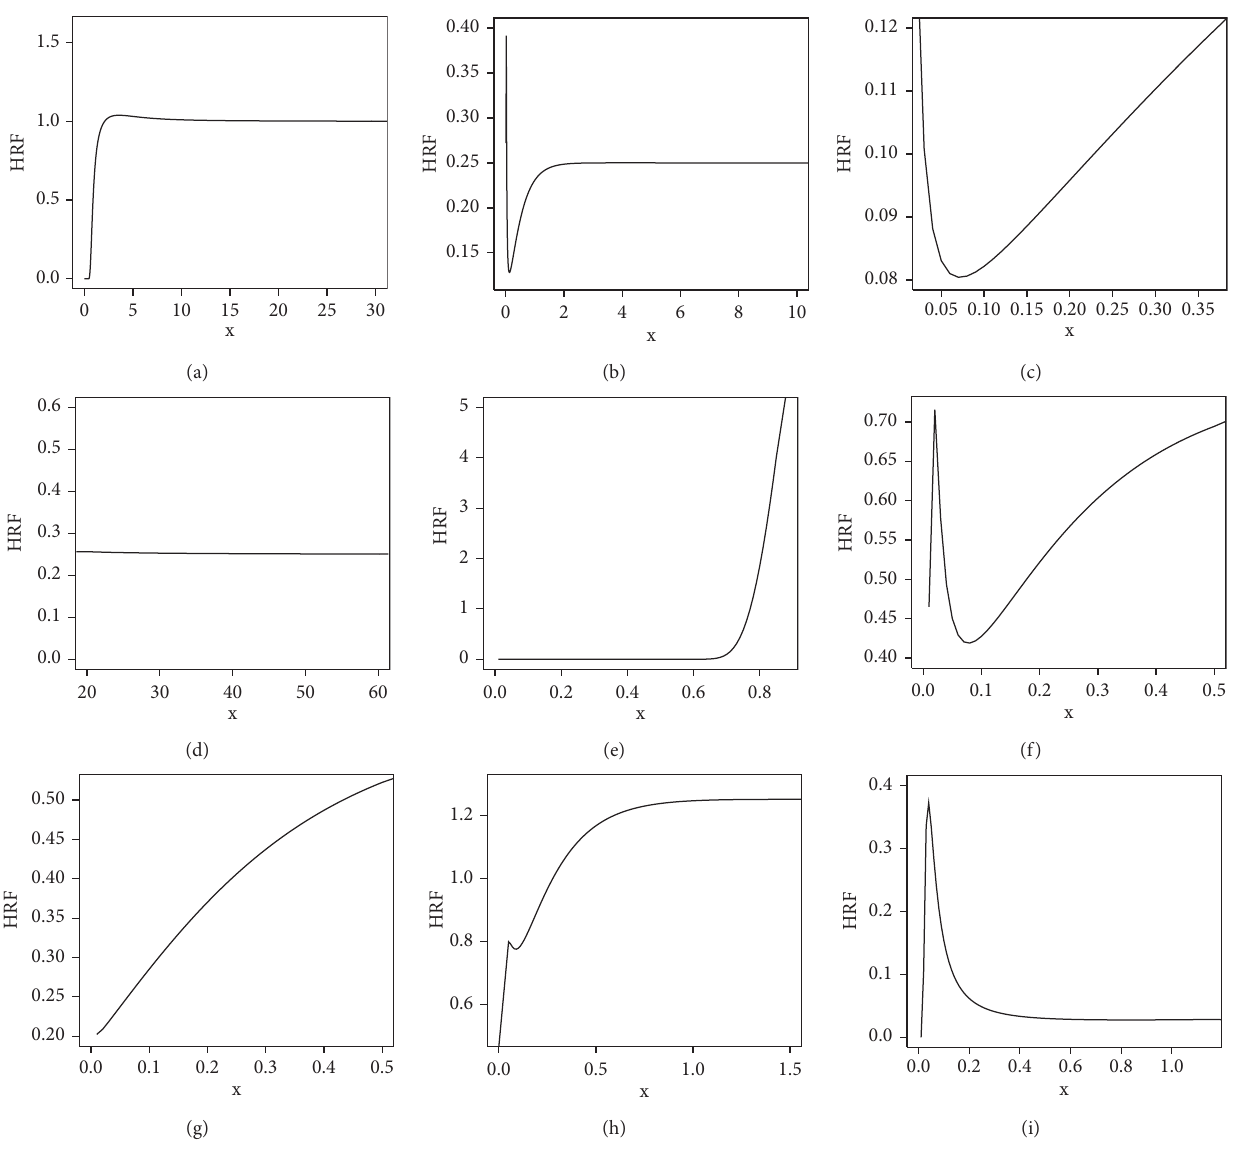
Figure 2: HRFs of the TIITLIFW model for some different values of the parameters. (a) α � 1 , θ � 1 , λ � 1. (b) α � 0 . 1 , θ � 2 . 5 , λ � 0 . 1. (c) α � 0 . 001 , θ � 2 , λ � 0 . 1. (d) α � 5 , θ � 0 . 5 , λ � 0 . 5. (e) α � 2 , θ � 2 , λ � 10. (f) α � 0 . 1 , θ � 5 , λ � 0 . 15. (g) α � 0 . 0001 , θ � 4 , λ � 0 . 15. (h) α � 0 . 25 , θ � 5 , λ � 0 . 25. (i) α � 0 . 25 , θ � 0 . 25 , λ � 0 .